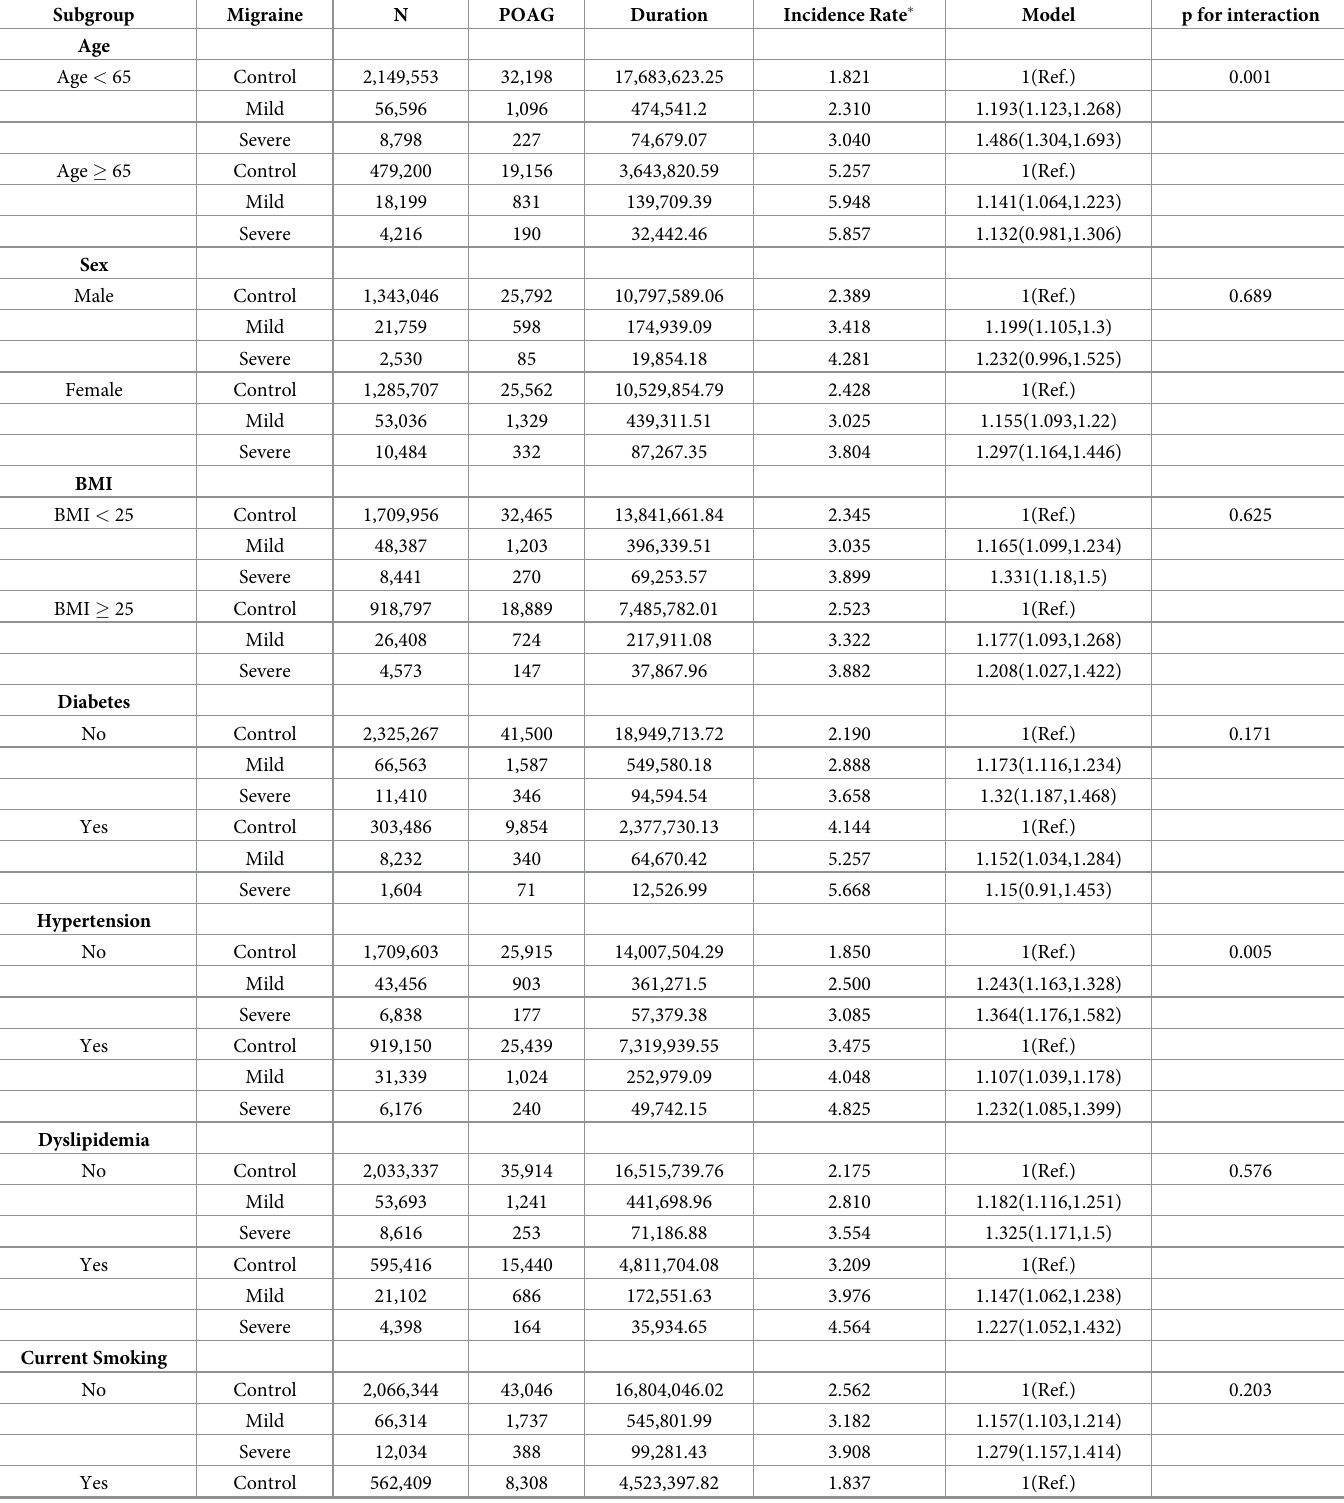
Table 4. Risk of POAG according to migraine severity stratified by age, sex, BMI, diabetes, hypertension, dyslipidemia, smoking, and drinking. Subgroup Incidence Rate � Model p for